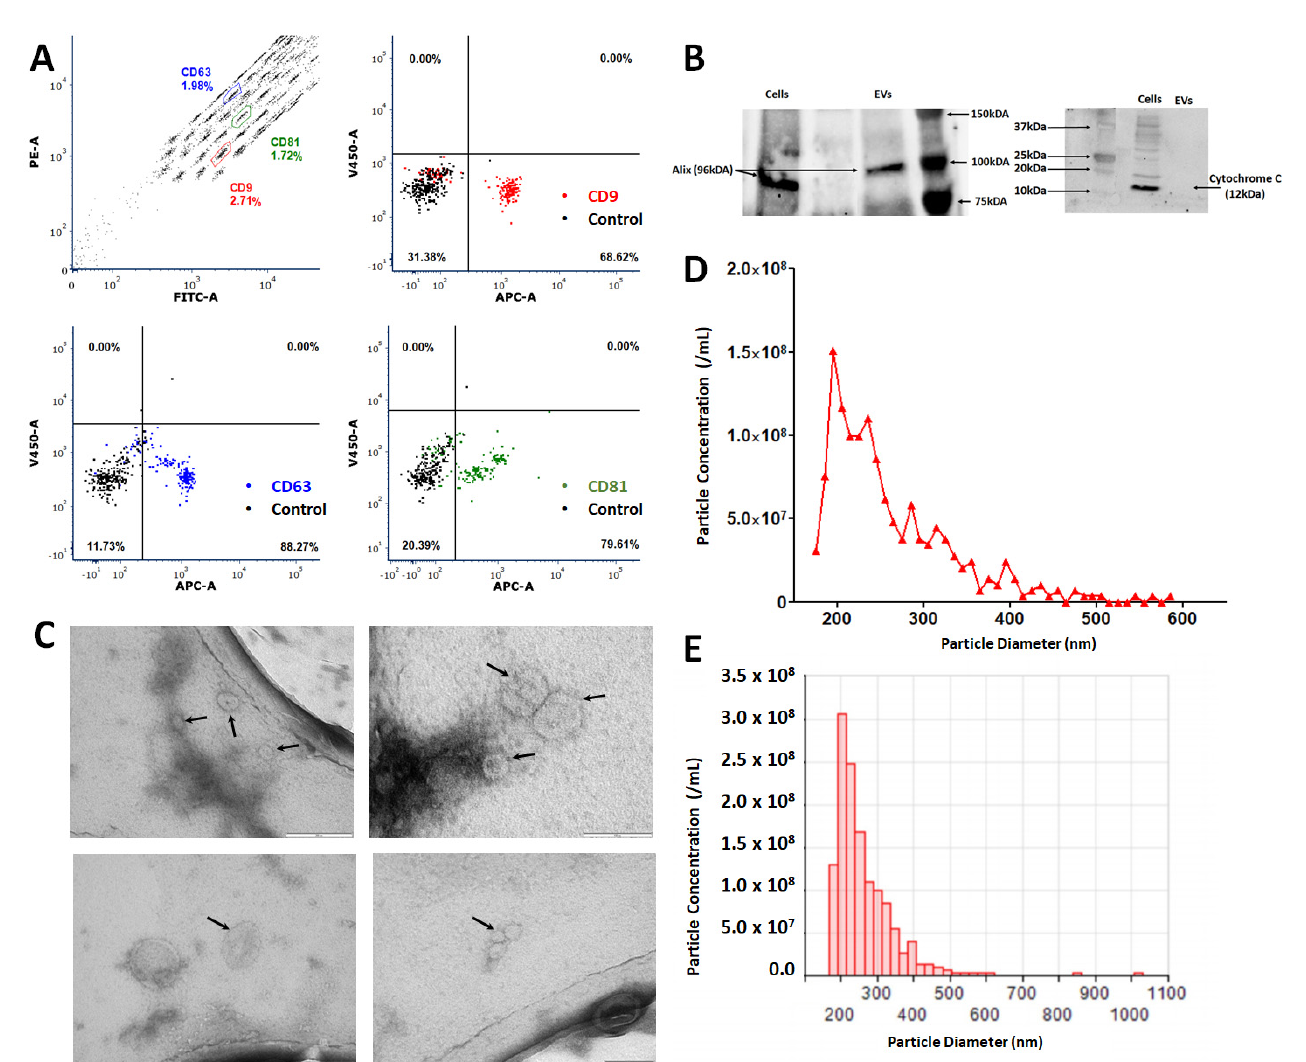
Figure 1. Characterisation of MSC-derived extracellular vesicles (EVs). ( A ) Representative flow cytometry analysis of standard culture-derived EVs (EV-NormO 2 ) preparations using MACSPlex exosome detection kit (Miltenyi) for the detection of CD9 (mean 81.25 ± 5.03); CD63 (mean 94.59 ± 2.23); and CD81 (mean 79.41 ± 9.07) with unstained control beads. ( B ) Western blotting demonstrates presence of Alix and absence of cytochrome C in EVs ( C ) TEM characterisation of hBM-MSC derived small EVs. Small EVs were re-suspended in sterile distilled water after isolation and spotted onto TEM grids before being stained with uranyl acetate. Black arrows indicate recorded small EVs. Small EVs were isolated from conditioned media taken from hBM-MSCs isolated from bone marrow aspirate cultured in hypoxic conditions (EV-2%O 2 ). ( D ) ( E ) Representative output from particle concentration and EV sizing Nanopore analysis (Izon) tuned in the region ~80–300 nm, highlighting EVs diameter range, with peak diameter averaging around 200 nm with maximal diameter around 500 nm ( n = 11).